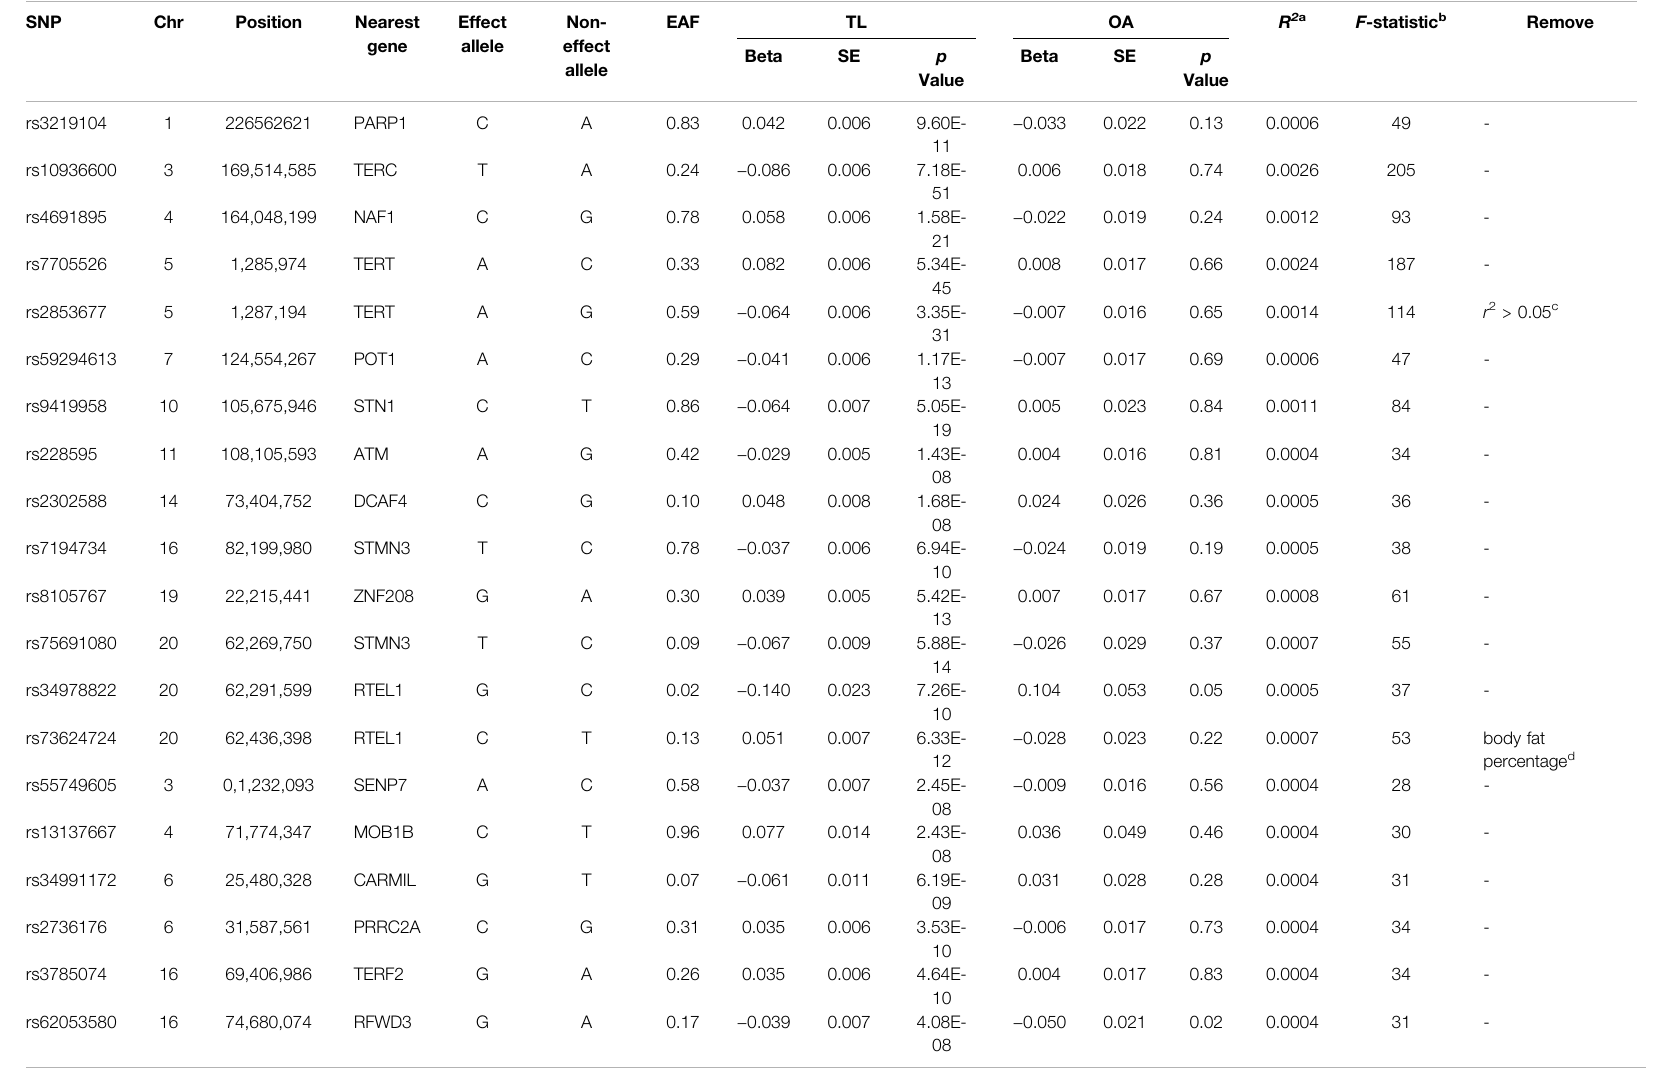
TABLE 1 | Characteristics of SNPs used as genetic instruments for TL in the present MR